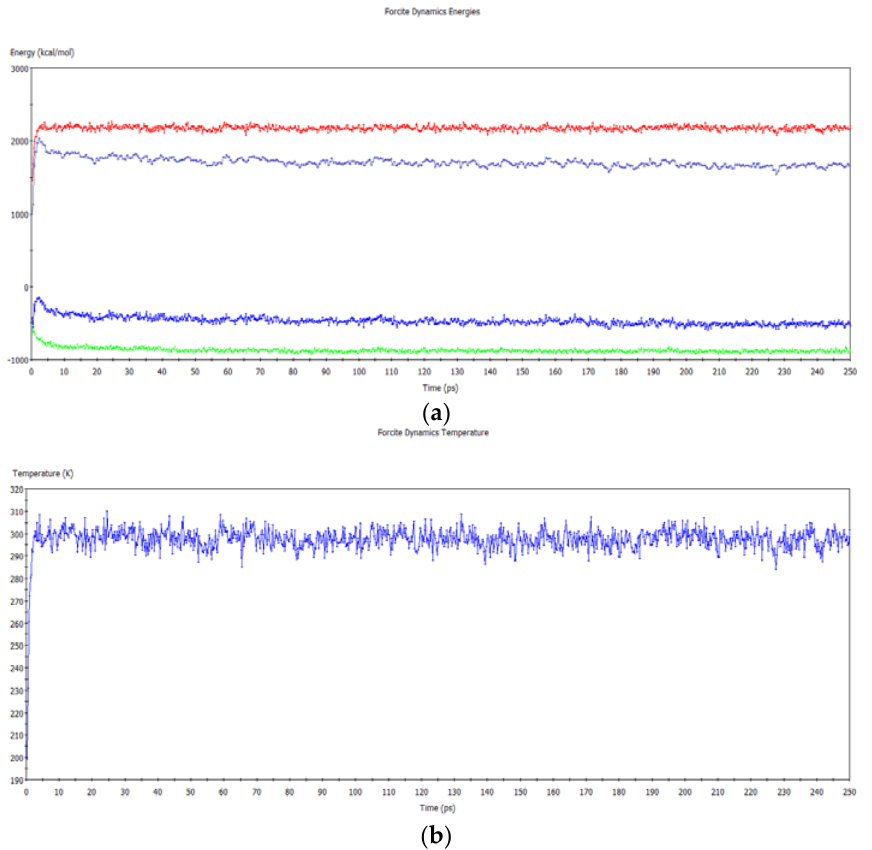
Figure 2. Dynamic energy-time ( a ) and temperature-time ( b ) curves of the molecular dynamics (MD) simulation. The red, light blue, dark blue and green curves in ( a ) represent kinetic energy, total energy, potential energy and non-bonded energy, respectively.